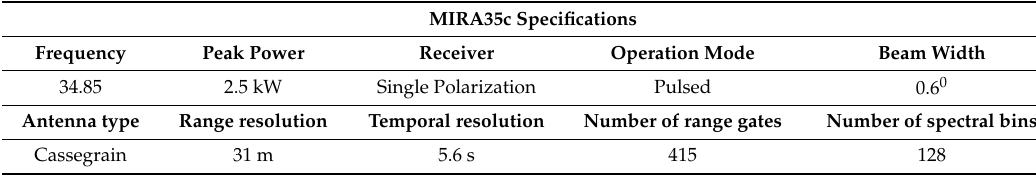
Table 1. Specification of MIRA35c.